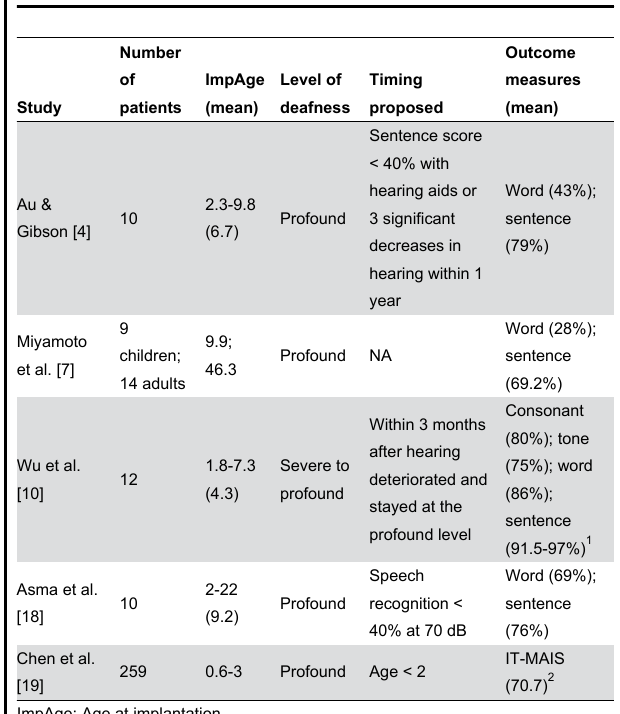
Table 1. Comparison among studies that addressed the timing of implantation and postsurgical speech perception